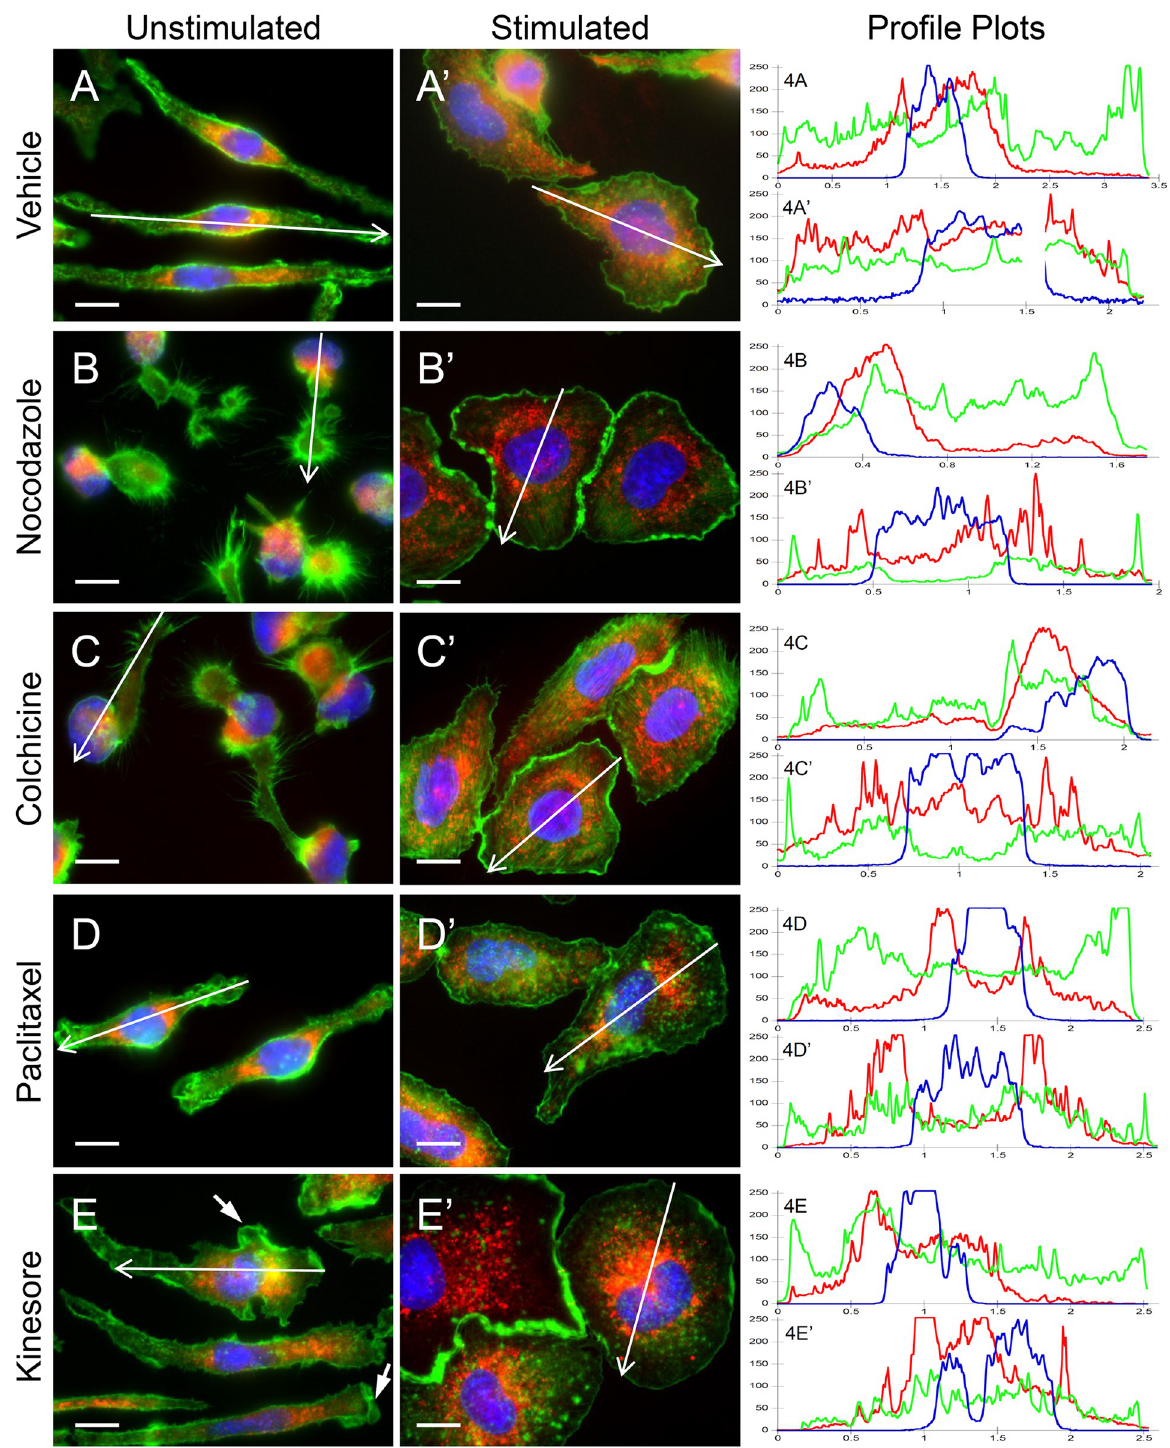
Fig 4. Microtubule drugs and the microtubule motor drugs, kinesore, affects cell morphology and granule distribution but not F-actin remodeling. RBL-2H3 cells were pretreated for 30 min with vehicle ( A , DMSO), 1 μ M nocodazole ( B ), 10 μ M colchicine ( C ), 10 μ M paclitaxel ( D ), or 100 μ M kinesore ( E ). Cells were left unstimulated or antigen-stimulated for 30 min, fixed and stained for nuclei (blue), F-actin (green), or CD63 + granules (red). Scale bar, 10 μ m. Profile plots ( right panels ) show the levels of CD63+ granules distributed in the indicated cross-sections. Drug pretreatment did not affect the formation of F-actin rich lamellipodia after stimulation, however CD63+ granules accumulated in the perinuclear region of drug treated cells ( B’-E’ , red ), while control cells ( A’ , red ) showed CD63+ granules were distributed across the entire cross-section. https://doi.org/10.1371/journal.pone.0265122.g004 PLOS ONE | https://doi.org/10.1371/journal.pone.0265122 March 22,